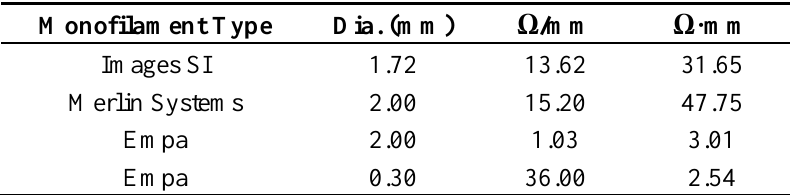
Table 3. List of monofilament, their nominal expected thicknesses, and their resistance values, based on 50 mm